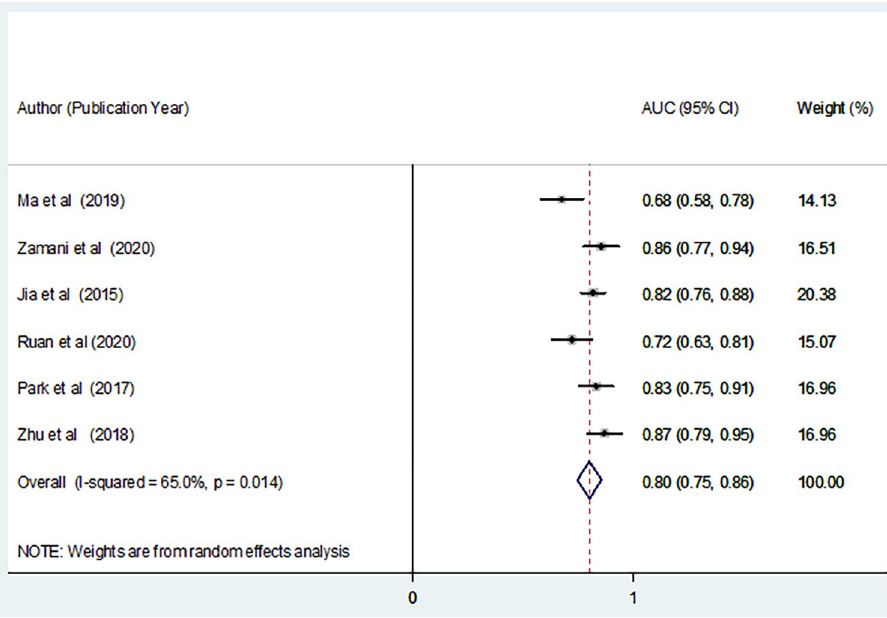
Fig 4. A forest plot depicting the area under the curve (AUC) of summary receiver operating characteristics (SROC) of microRNA-21 assay diagnostic value in cervical cancer.